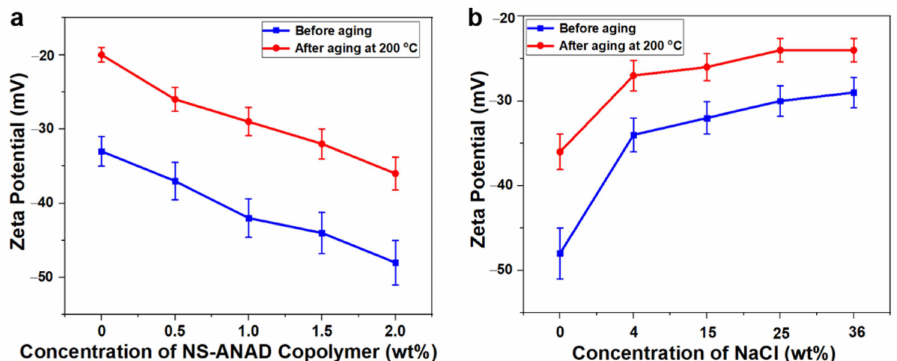
Figure 7. ( a ) Zeta potential curves of NS-ANAD-based drilling fluids before and after aging at 200 ◦ C. ( b ) Zeta potential curves of 2 wt% NS-ANAD co-polymer-based drilling fluids with different fractions of NaCl before and after aging at 200 ◦